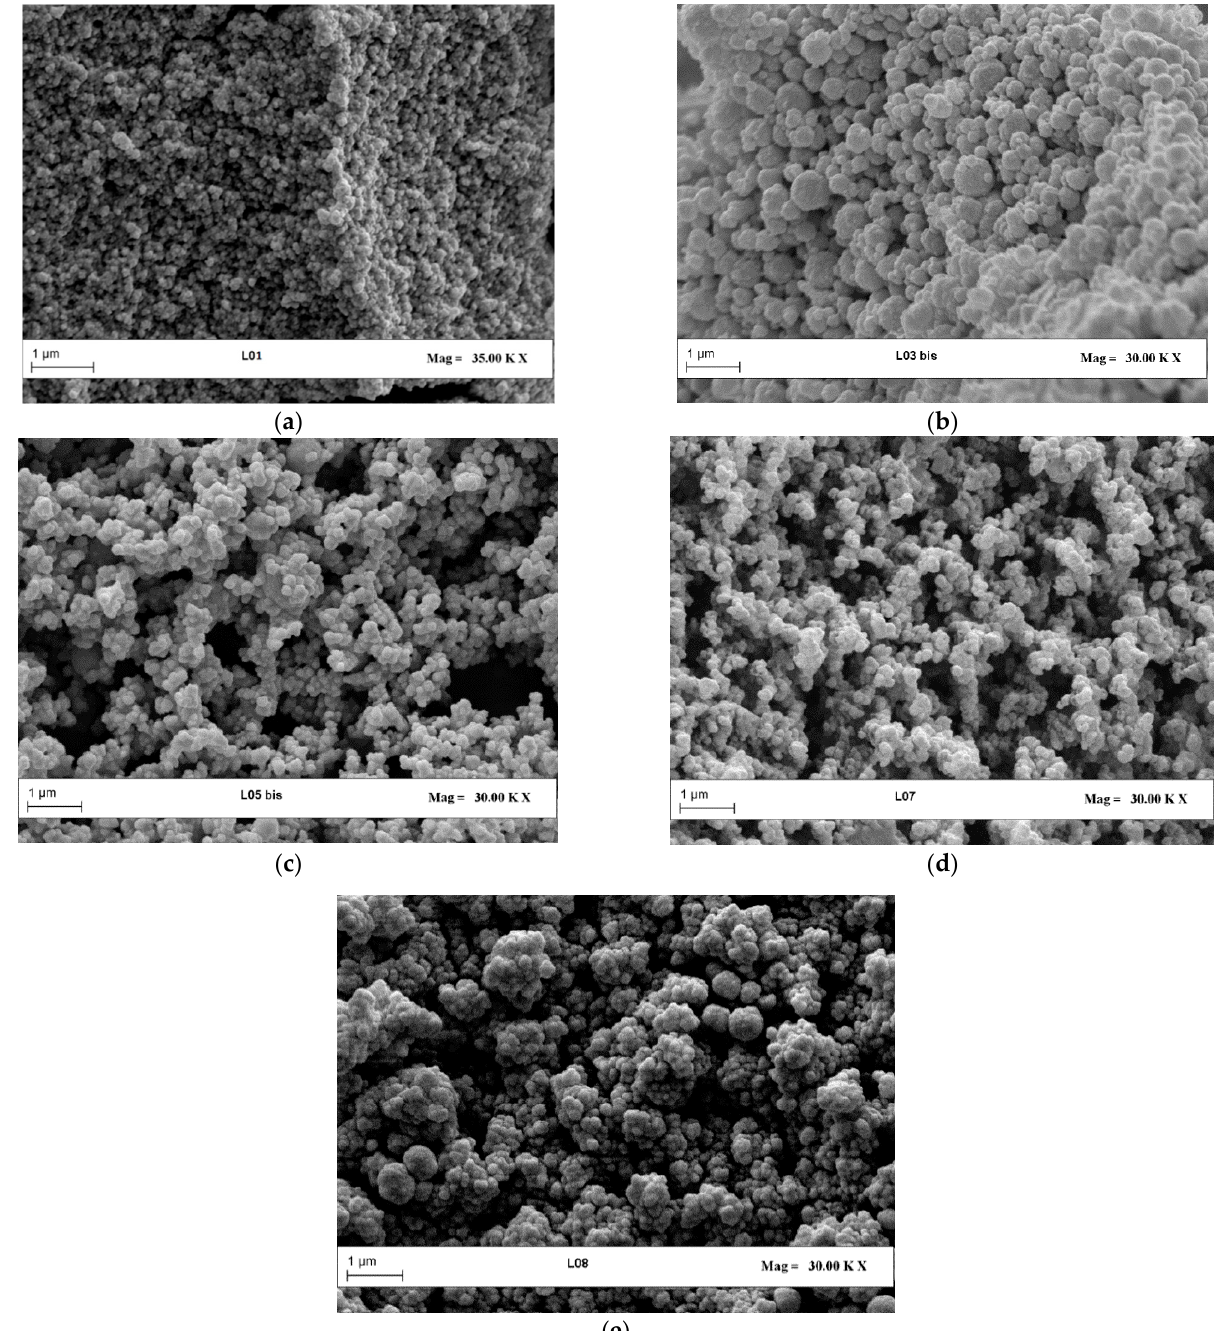
Figure 4. Scanning Electron Microscope observations of liposomes produced using SuperLip. ( a ) Lut1 (100 bar, 35 °C, and 1% DLR), ( b ) Lut3 (100 bar, 45 °C, and 1% DLR), ( c ) Lut 5 (150 bar, 45 °C, and 1% DLR), ( d ) Lut7 (100 bar, 45 °C, 0.5%), ( e ) Lut8 (150 bar, 35 °C, 0.5% DLR).